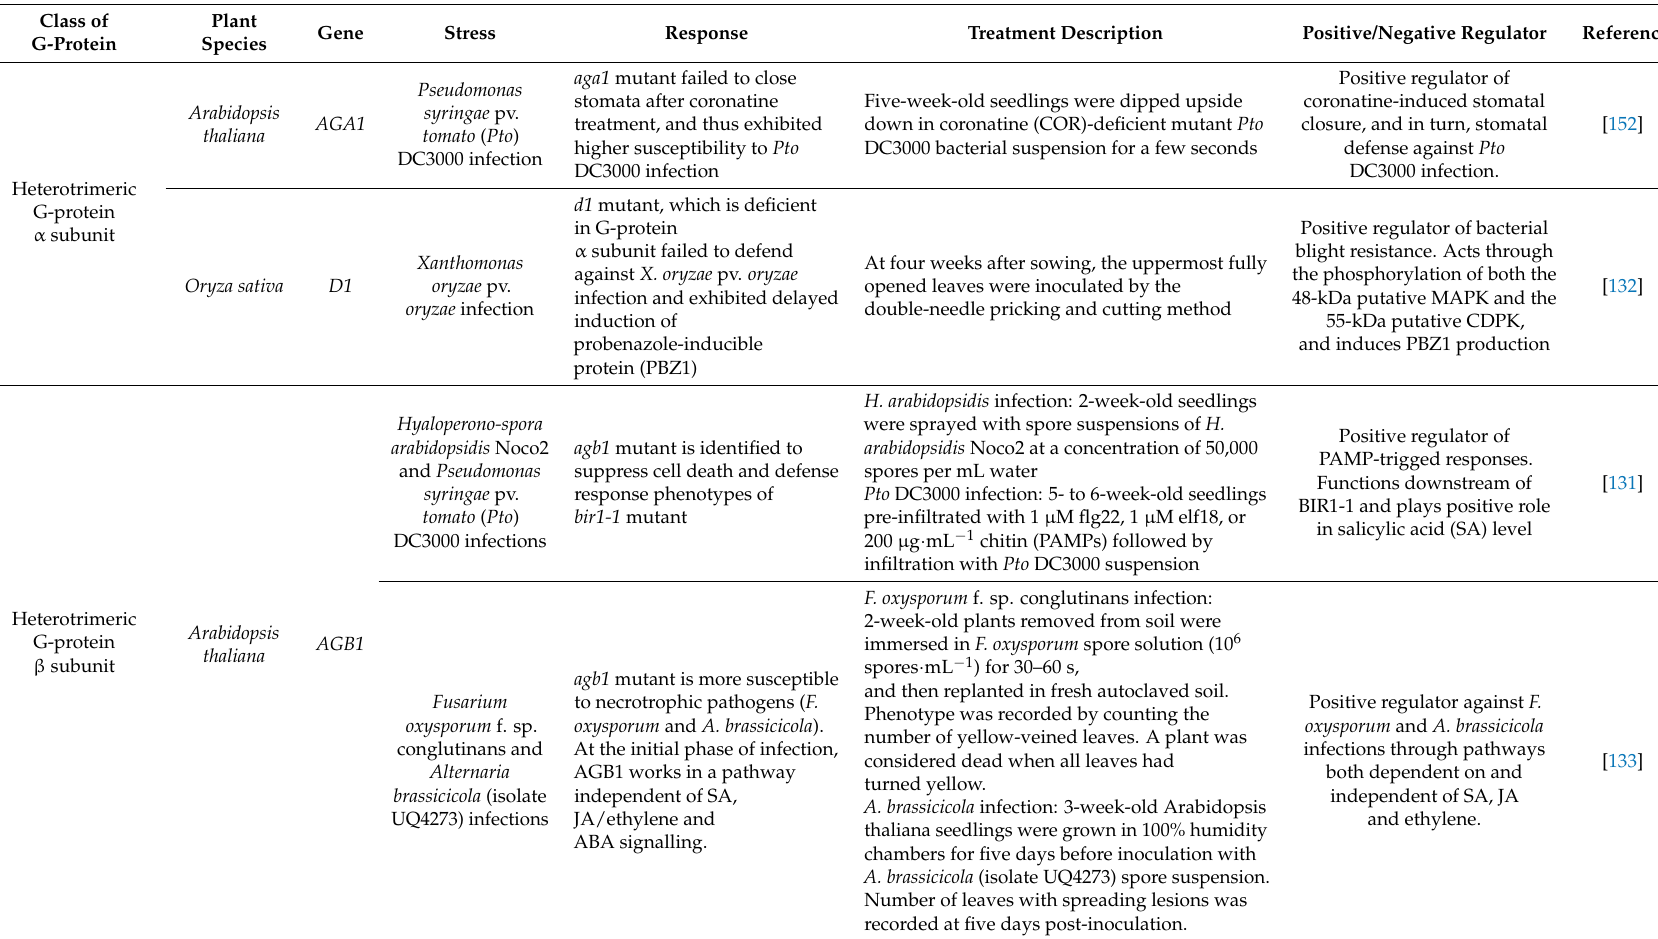
Table 3. G-proteins and their roles in biotic and abiotic stress